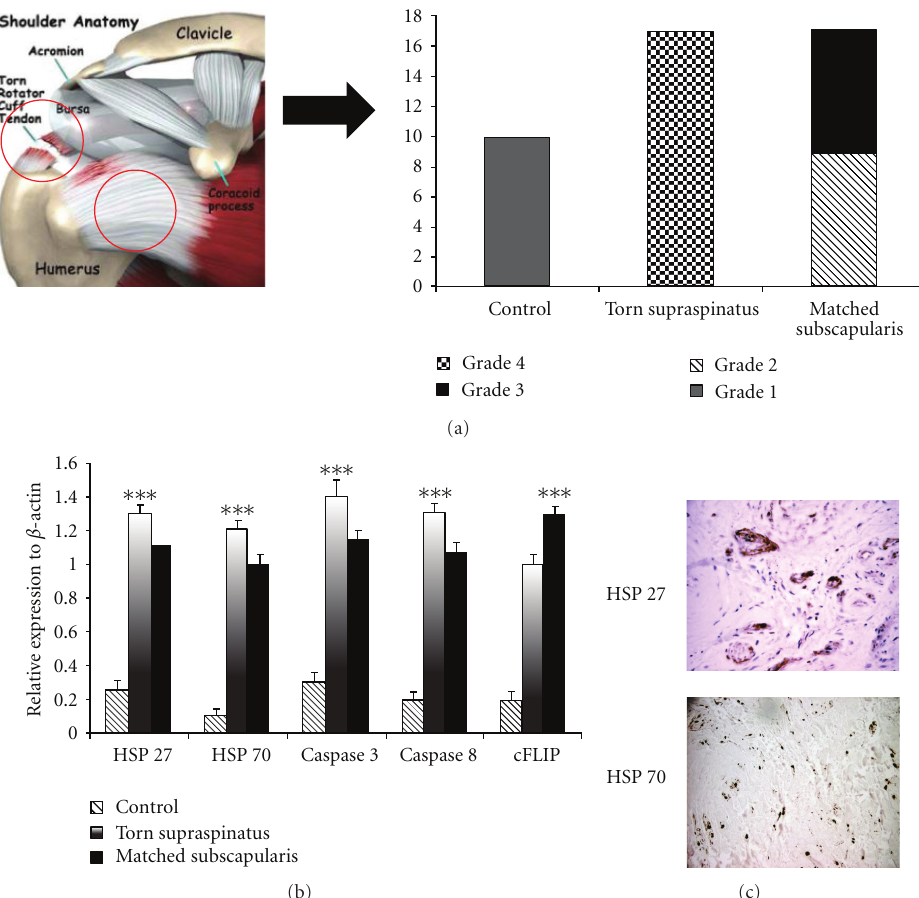
Figure 2: Heat shock proteins in early human tendinopathy. (a) Biopsies from subscapularis tendon revealed grade 1-2 pathological changes (mucoid degeneration, increased neovascularisation) in keeping with early tendinopathy. This was a chance finding when using this tissue as an internal control. This has subsequently allowed us to investigate alarmin molecule in early stressed tendon tissue. (b) These biopsies subsequently showed a significant increase in heat shock protein mRNA in tendon pathology. The bar graph illustrates the relative expression of apoptosis and HSP genes in human tendon samples. The data are displayed as the mean ± SEM, n = 17 for supraspinatus and matched subscapularis, n = 10 for control group ( ∗ P < 0 . 01; ∗∗ P < 0 . 001). (c) The immunohistochemistry of heat shock protein HSP27 and HSP70 is shown in torn human subscapularis tendon (a) and in torn human supraspinatus tendon (b) (magnification ×